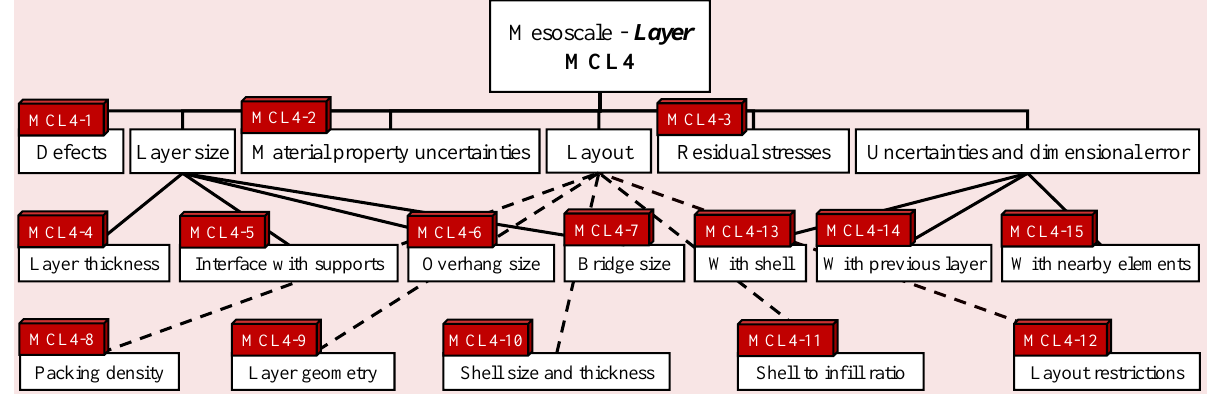
Figure 10. Essential manufacturing constraints at the single-layer mesoscale level.